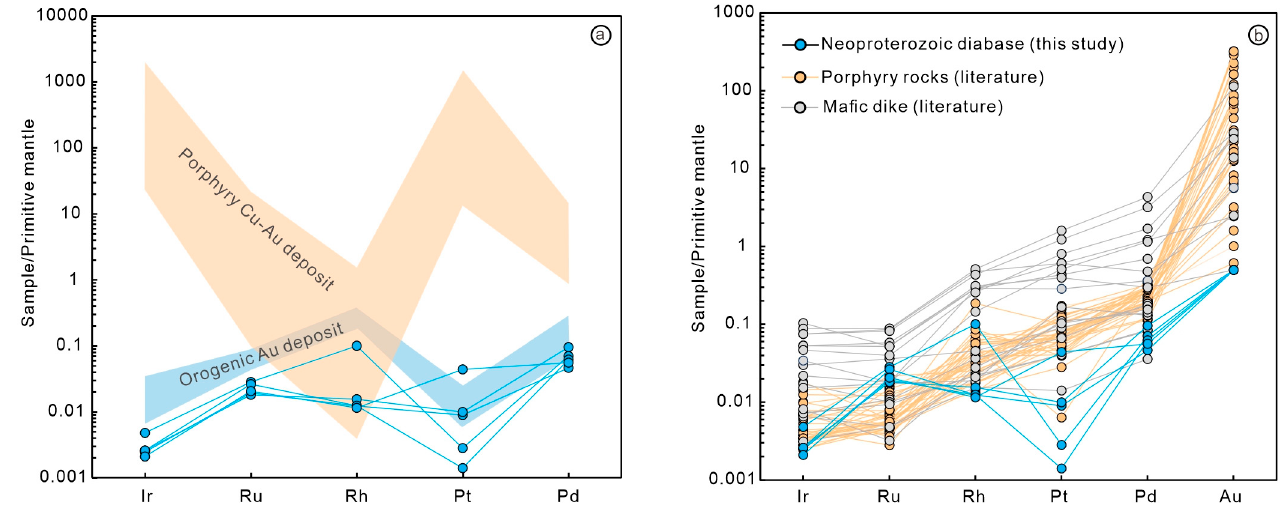
Figure 7. Primitive mantle-normalized PGE and Au contents for the Aksu Neoproterozoic diabase dykes. Data sources: Danba gold deposit [3], Porphyry Cu–Au deposits [62], Zhengyuan lampro- phyres [59], Victoria gabbro [58], Yilgarn Craton lamprophyres [60], and Tuwu felsic intrusions [61]. Literature data are compiled in Supplementary Table S2.